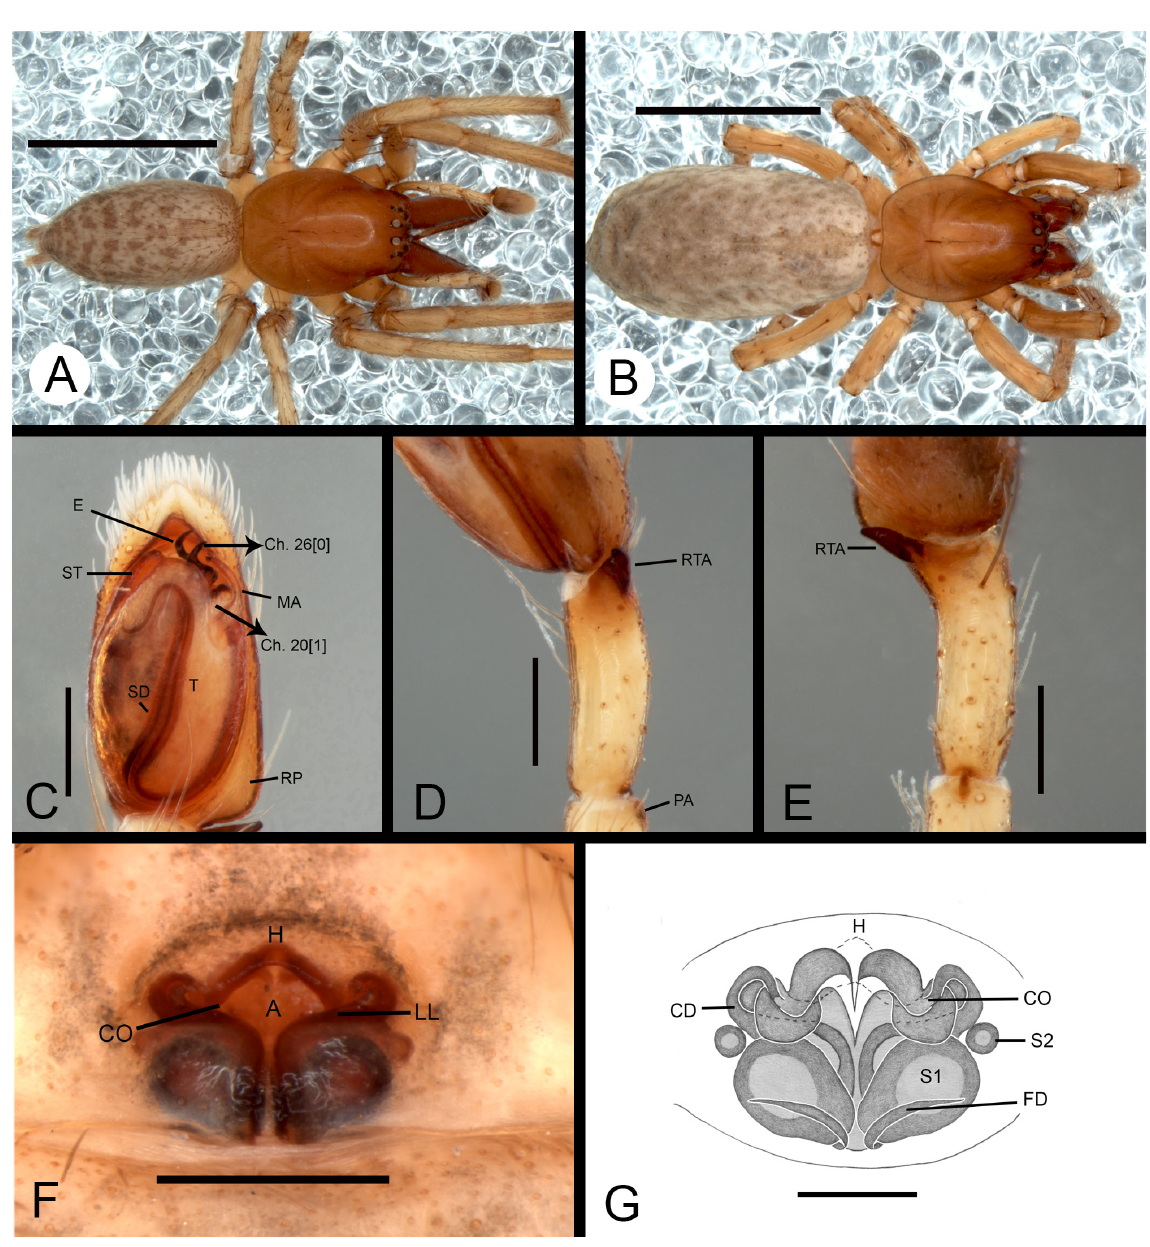
Fig. 10. Tafana riveti Simon, 1903 (A, C–E = ♂, MCZ; B, F–G = ♀, MCZ). A . Habitus, dorsal view. B . Habitus, dorsal view. C . Left palp, ventral view (arrow indicating character). D . Left palp, retrolateral view. E . Left palp, dorsal view. F . Epigynum, ventral view. G . Vulva, dorsal view. Abbreviations: A = atrium; Ch = character; CD = copulatory ducts; CO = copulatory opening; E= embolus; FD = fertilization ducts; H = hood; LL = lateral lobes; MA = median apophysis; PA = patellar apophysis; RP = retrolateral projection; RTA = retrolateral tibial apophysis; SD = sperm duct; ST= subtegulum; S1 = primary spermathecae; S2 = secondary spermathecae; T = tegulum. Scale bars: A–B = 3.5 mm, C–E, G = 0.25 mm, F = 0.4